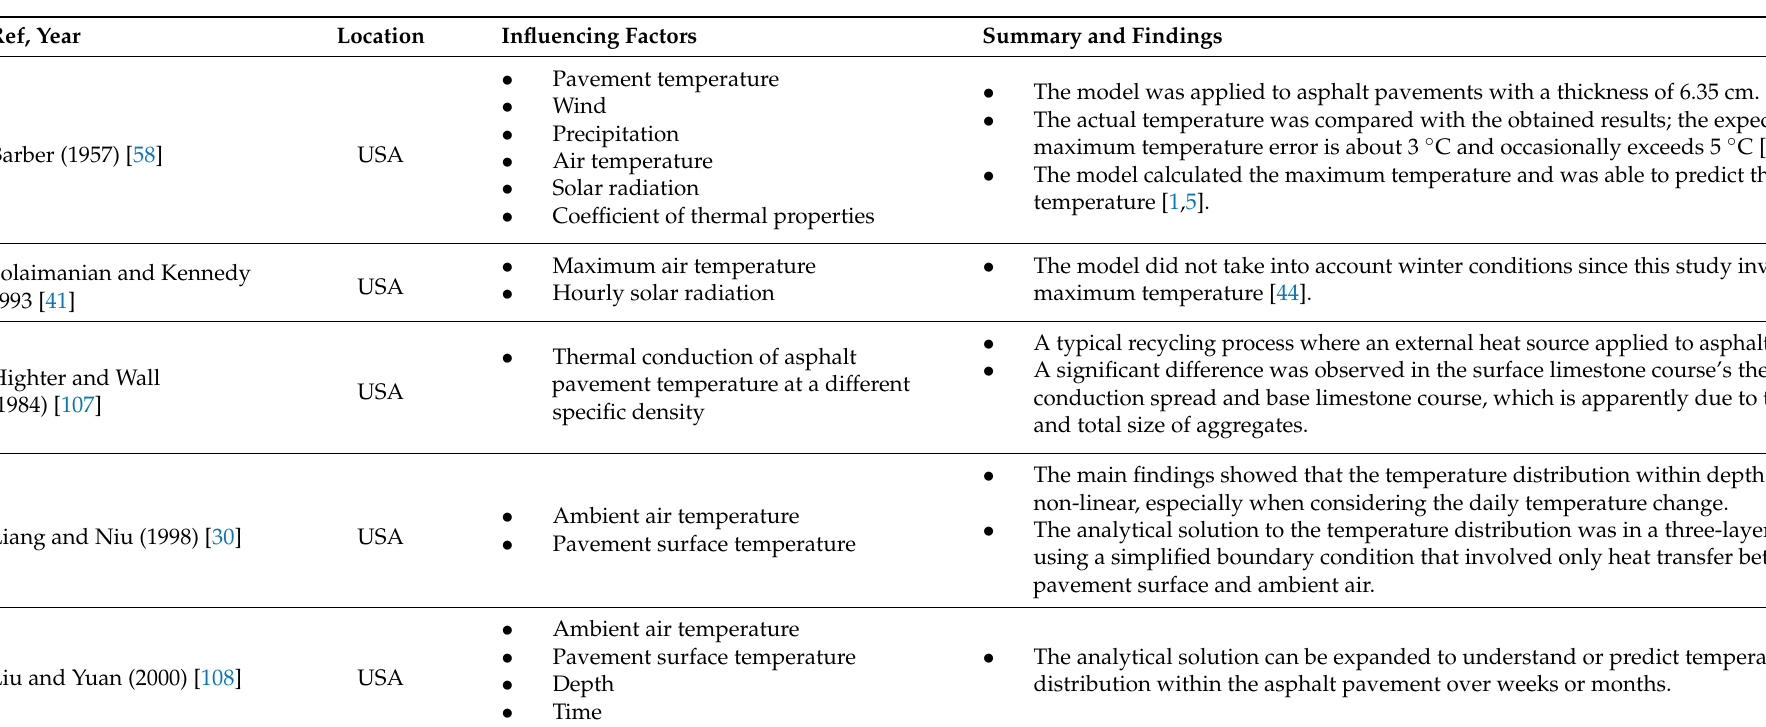
Table 2. Pavement temperature prediction models using analytical